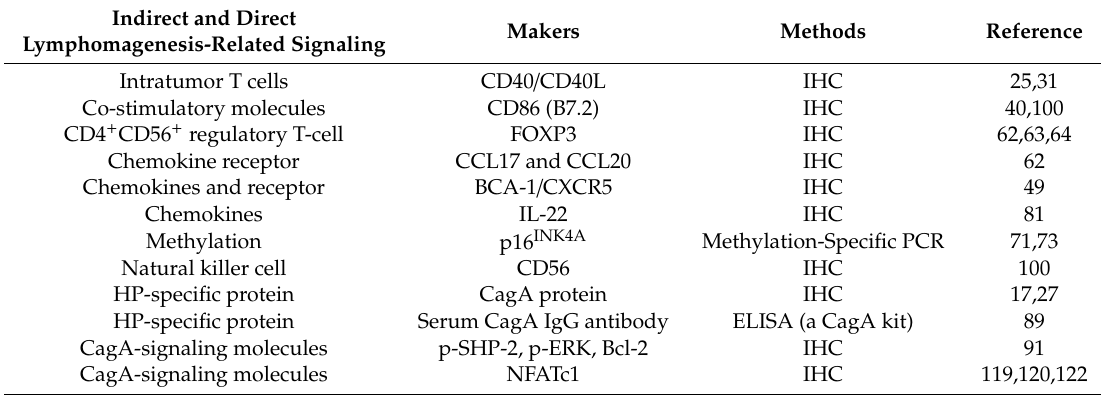
Table 1. Biologic markers are associated with the antibiotics-responsiveness of gastric MALT lymphoma patients who received a first-line antibiotics